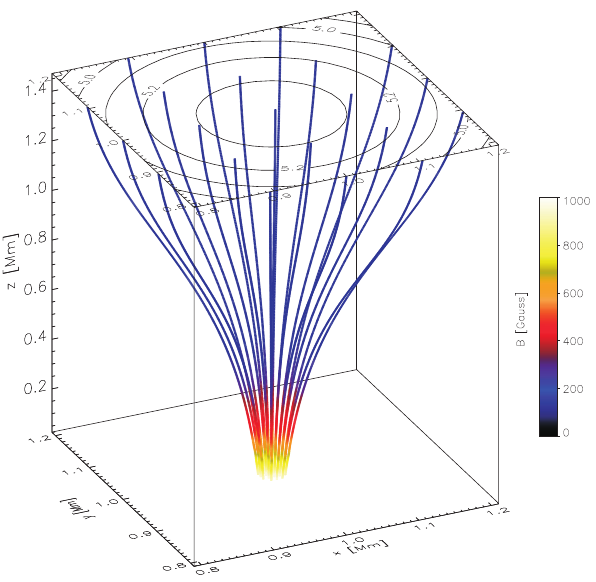
Fig. 1. Initial magnetic flux tube configuration. Selected colored lines correspond to the magnetic field lines. Also, color indicates the value of the magnetic field strength at different regions of the flux tube. The iso-contours of the initially constant magnetic field are overplotted at the top of the simulation box. Note, only central part (i.e. x,y =[ 0 . 8 , 1 . 2 ] Mm) of the full computational domain (i.e. x,y =[ 0 , 2 ] Mm) is